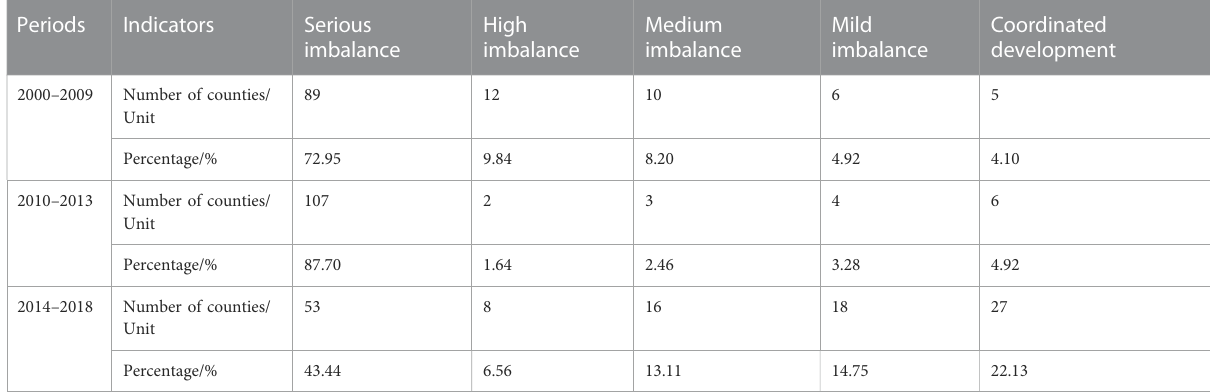
TABLE 5 Statistics of the types of country coordination degrees in different periods.